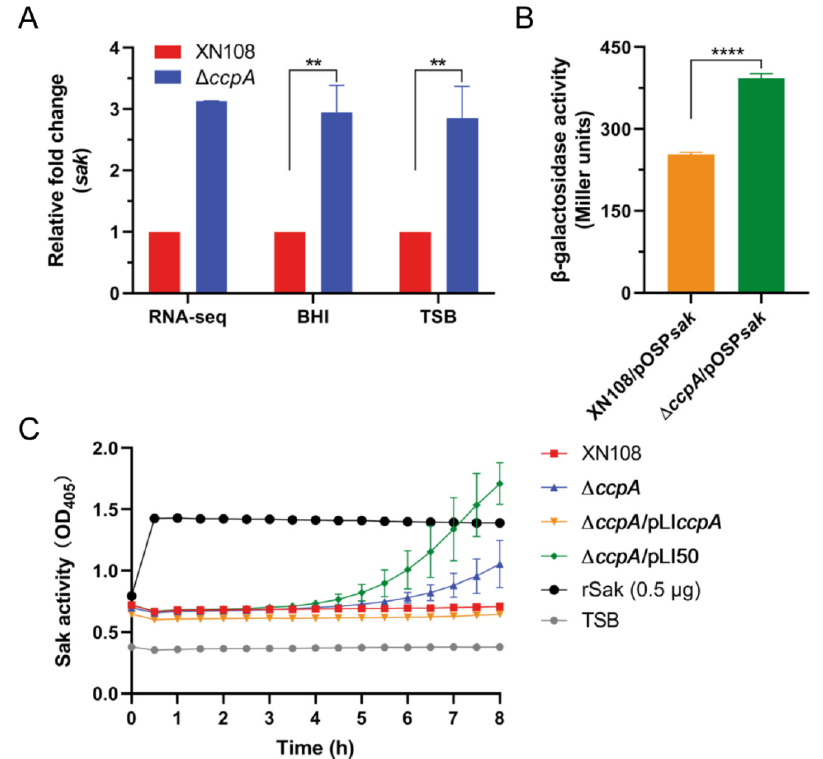
Figure 3. CcpA negatively regulates sak expression. ( A ) RT-qPCR analysis of sak transcription. S. aureus strain XN108 and ∆ ccpA were cultivated in TSB and BHI medium, respectively. Total RNA was collected from mid-exponential phase cultures and subjected to RT-qPCR analysis. The data are expressed as the mean ± SD from three independent experiments. **, p < 0.01. ( B ) Promoter activity of sak . WT and ∆ ccpA containing the P sak - lacZ fusion reporter plasmid were cultured in TSB medium to the mid-exponential phase, and the β -galactosidase activities were then measured. The data are expressed as the mean ± SD from three replicates. ****, p < 0.0001. ( C ) Measurement of Sak activity. WT and derivatives differing in ccpA expression were grown in TSB medium, and the activities of secreted Sak in the supernatants were detected using a chromogenic assay, in which the supernatants were incubated with human glu-plasminogen and plasmin-specific chromogenic substrate S-2251 successively, and the values for optical density at 405 nm (OD 405 ) of the reactions were measured every 30 min for a total of 8 h. Plain TSB supplemented with rSak was used as positive control, and plain TSB was negative control. The data are represented as the mean ± SD from